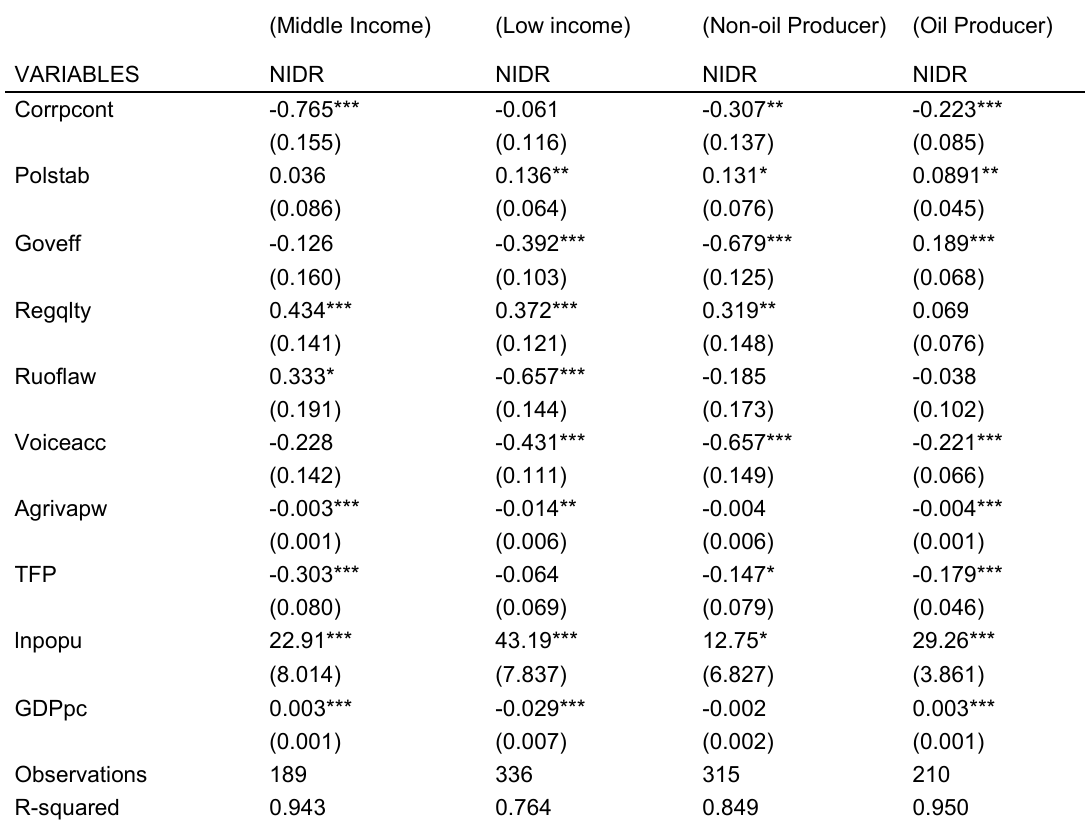
Table 5. Regression results for governance indicators and net-import dependency in different country